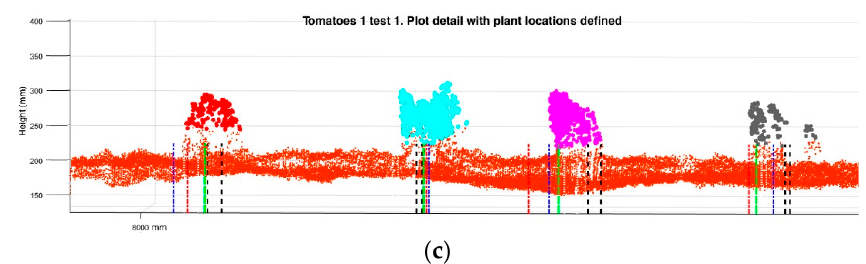
Figure 12. Plant and sticks location results obtained by the three different methods: Centre of the cluster; lowest point; and ground-plant intersection. ( a ) Sticks row data using LiDAR; ( b ) Tomato plants detected during Test 1 on row 1; ( c ) Detail of the aerial point cloud of tomato plants generated by the LiDAR during Test 1 on row 1. Each plant location method is marked with different coloured dotted line.